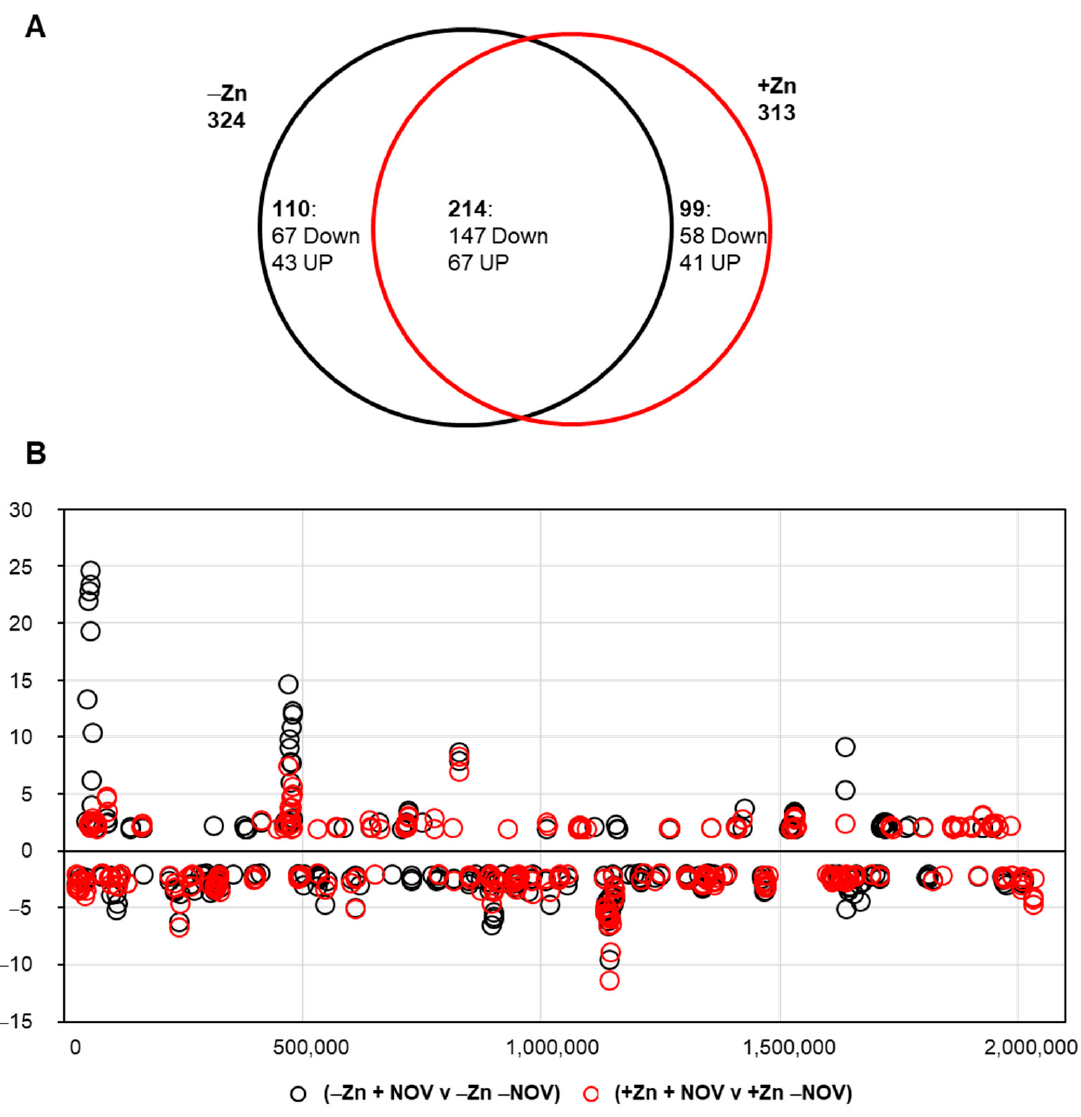
Figure 8. Number and localization of DEGs in the Δ staR P Zn staR chromosome upon treatment with NOV in the presence or absence of StaR. Cultures were grown to OD 620 nm = 0.2, diluted 50-fold in medium either without or with 150 μ M ZnSO 4 and grown to OD 620 nm = 0.4. Samples taken at this point were considered as non-treated with NOV. NOV-treated samples were grown for another 30 min with 0.5 × MIC of NOV. Total RNA was isolated and sequenced as described in the Materials and Methods section. ( A ) Venn diagram showing DEGs upon treatment with NOV in the absence or presence of ZnSO 4 . ( B ) The relative fold variation of each gene represented against the 5 ′ location of each open reading frame in the S. pneumoniae R6 chromosome (bases 1 to 2,038,615). A fold change ≥ 2 (absolute value) and a p -value-adjusted ≤ 0.01 were